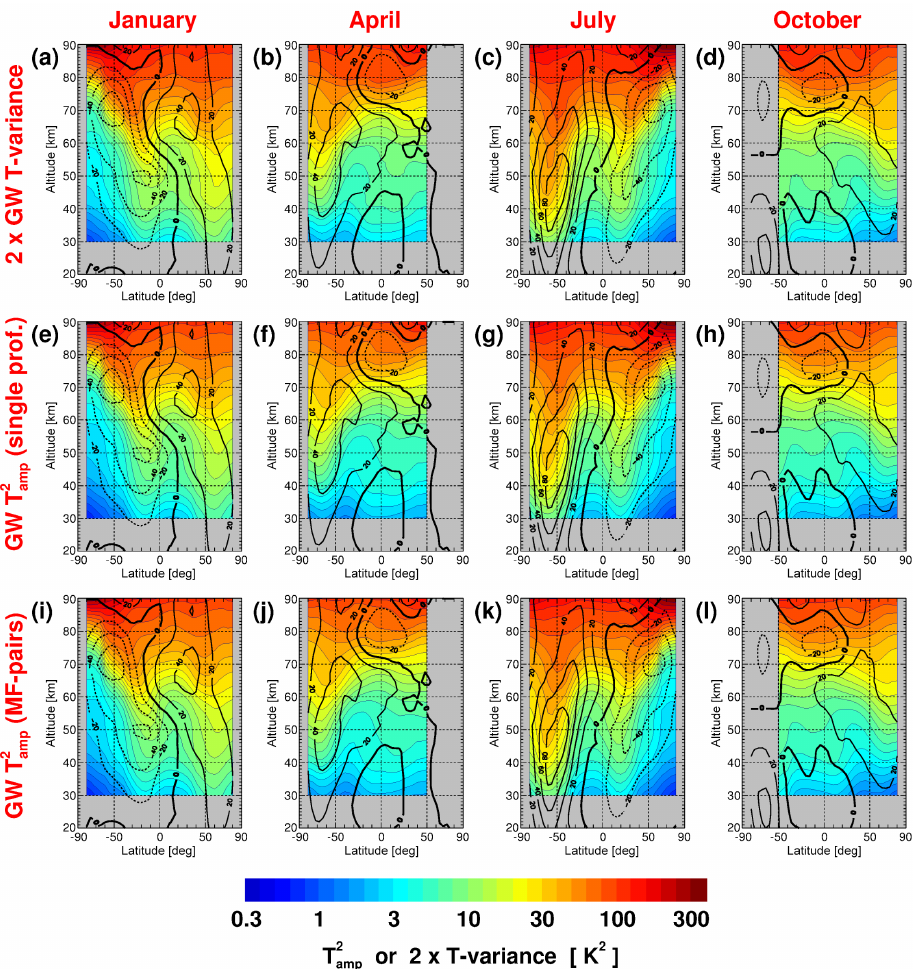
Figure 4. Latitude–altitude cross sections of SABER zonal-average gravity wave temperature variances times 2 (a–d) , gravity wave squared amplitudes of single altitude profiles (e–h) , and gravity wave squared amplitudes of pairs of altitude profiles utilized for determination of absolute momentum fluxes (i–l) . Values are for average January (a,e,i) , April (b,f,j) , July (c,g,k) , and October (d,h,l) . Overplotted winds are from the SPARC climatology (Swinbank and Ortland, 2003; Randel et al., 2002, 2004). Westward (eastward) winds are indicated by dashed (solid) contour lines. The zero wind line is bold solid. The contour line increment is 20ms − 1